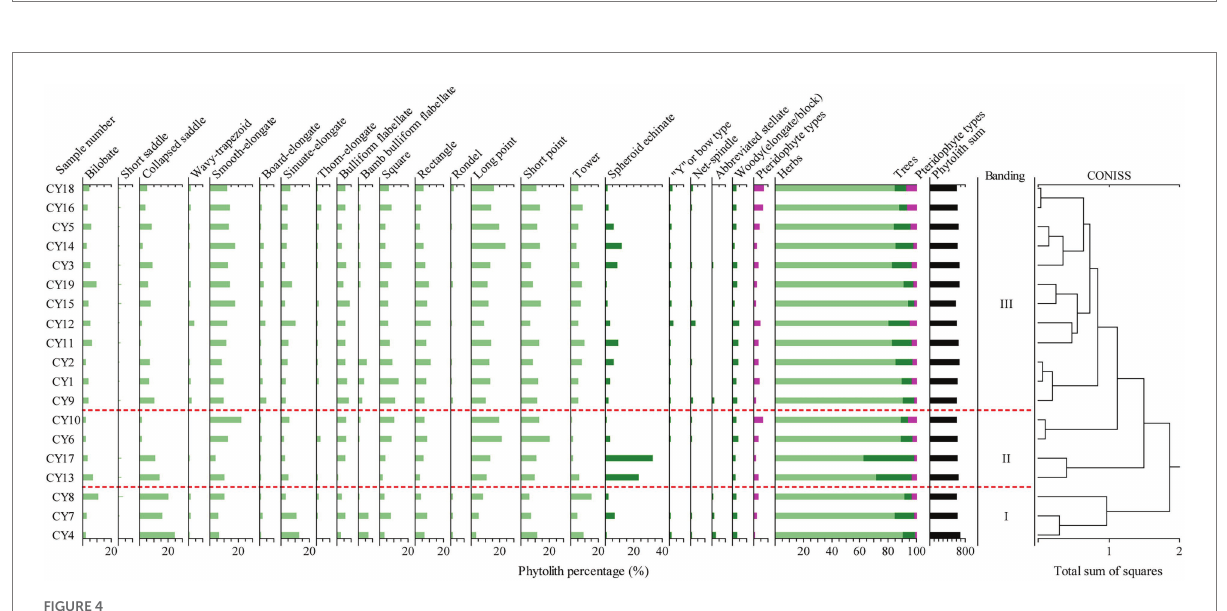
FIGURE 4 Chart of the percentage content of topsoil phytoliths in the research